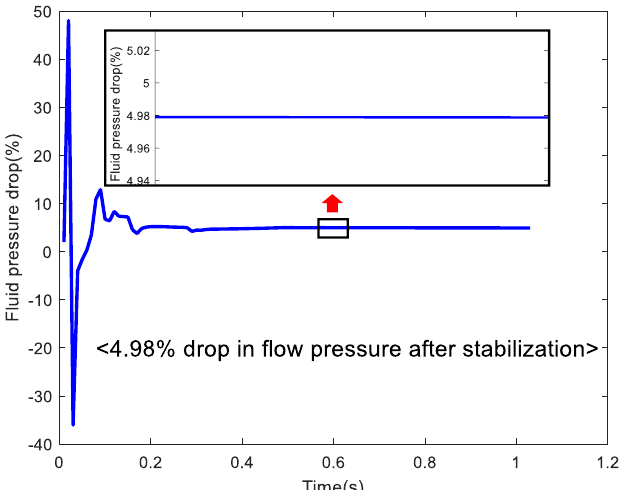
Figure 12 . Comparison of the pressure of BFS channel and flat type channel.